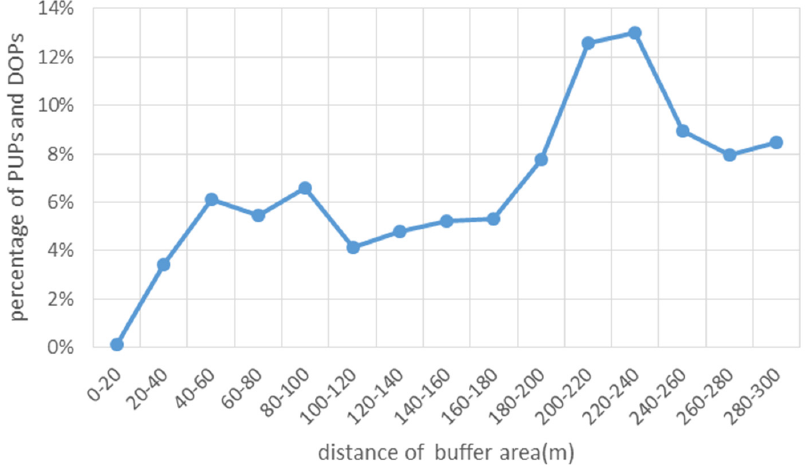
Figure 3. Percentage of PUPs and DOPs in buffer areas with different distances.